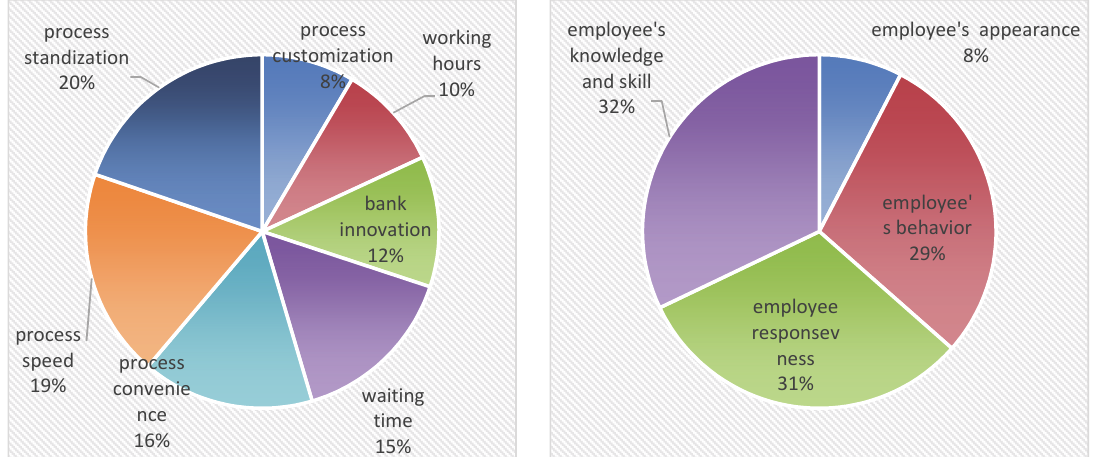
Fig 3. Weight of the sub-factor of dervice process Fig 4. Weight of the sub-factor of interaction